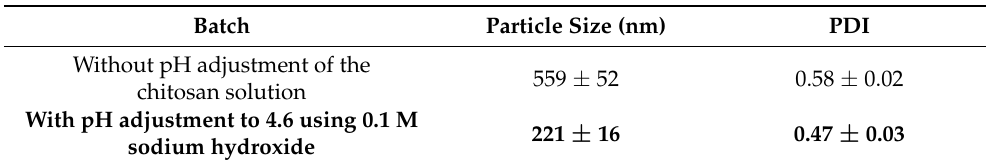
Table 2. Optimization of pH adjustment of chitosan solution for BC-NPs. Data are represented as mean ± SD ( n = 3). Batch Particle Size (nm) PDI Without pH adjustment of the 559 ± 52 0.58 ± 0.02 chitosan solution With pH adjustment to 4.6 using 0.1 M 221 ± 16 0.47 ± 0.03 sodium hydroxide